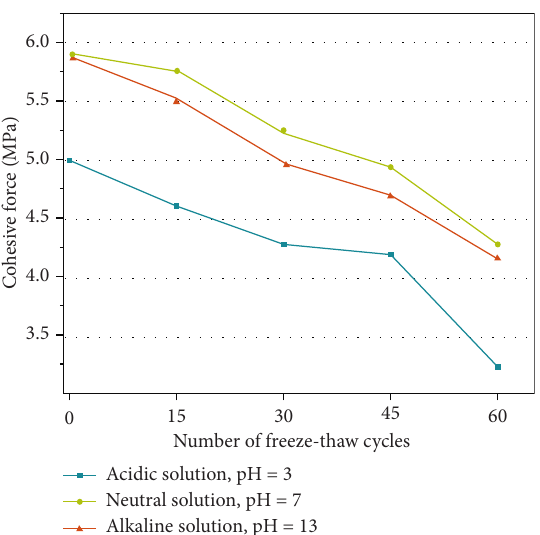
Figure 11: Curve of the number of freeze-thaw cycles and cohesion between different chemical